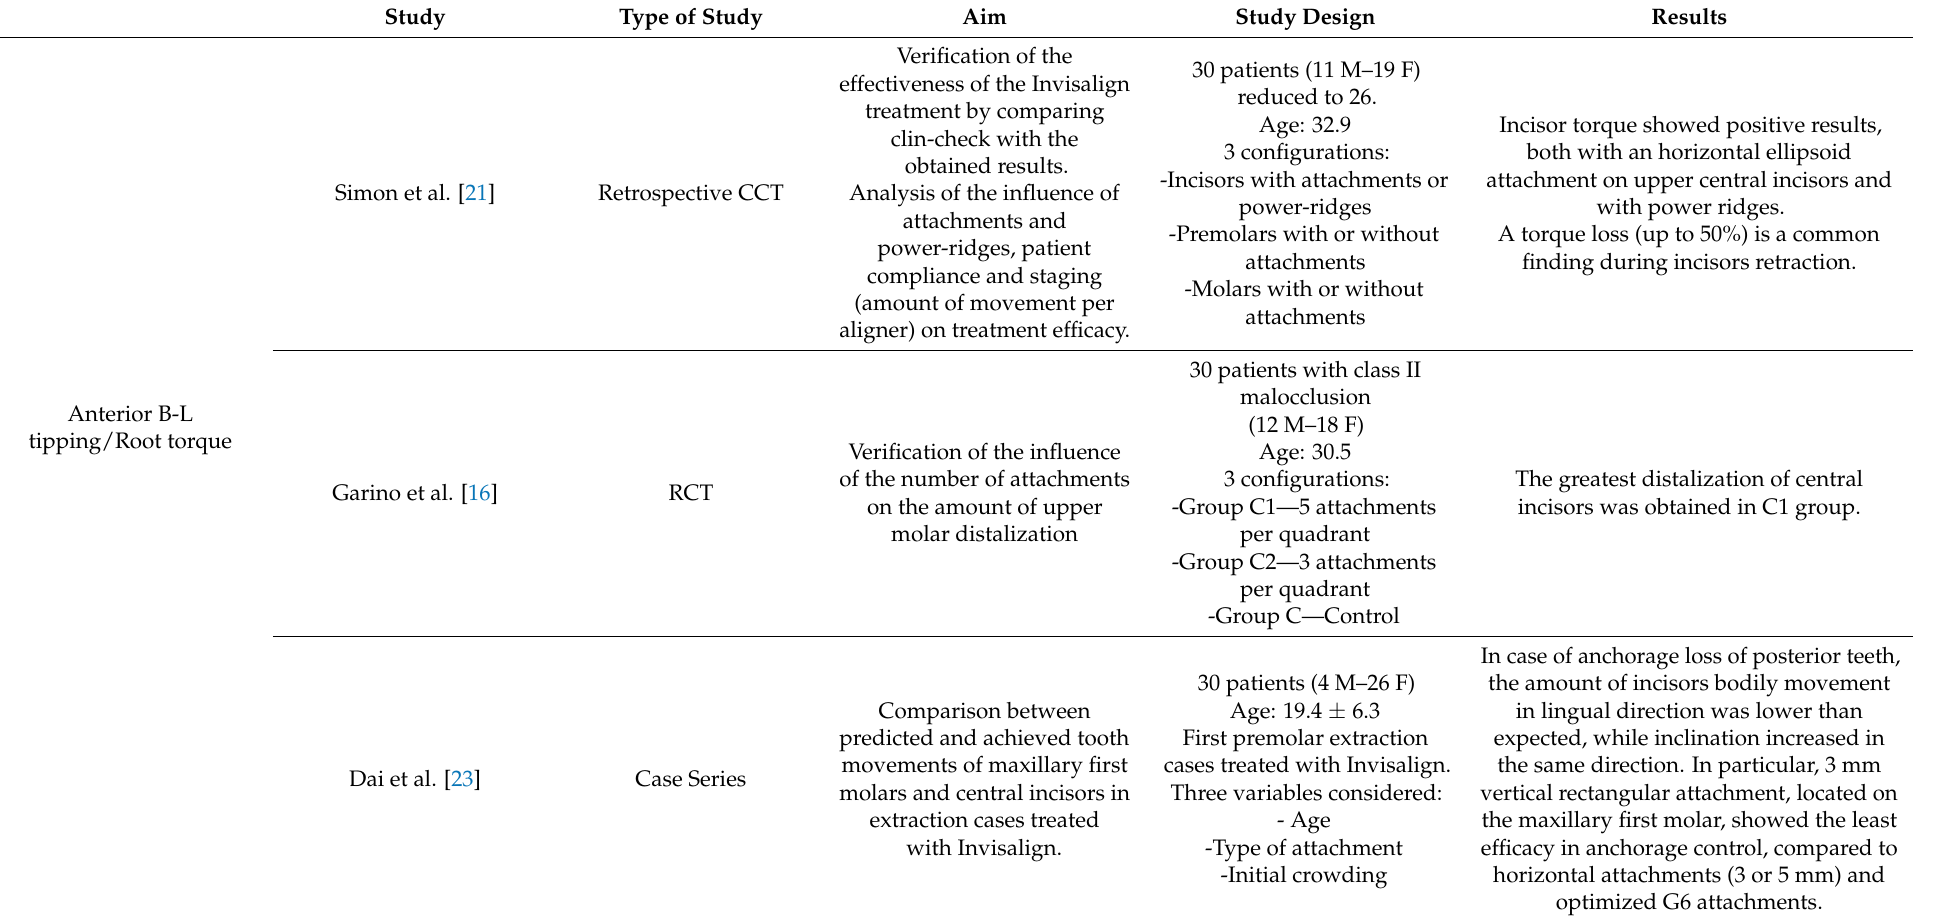
Table 4. Analysis of the results (grouped according to the type of